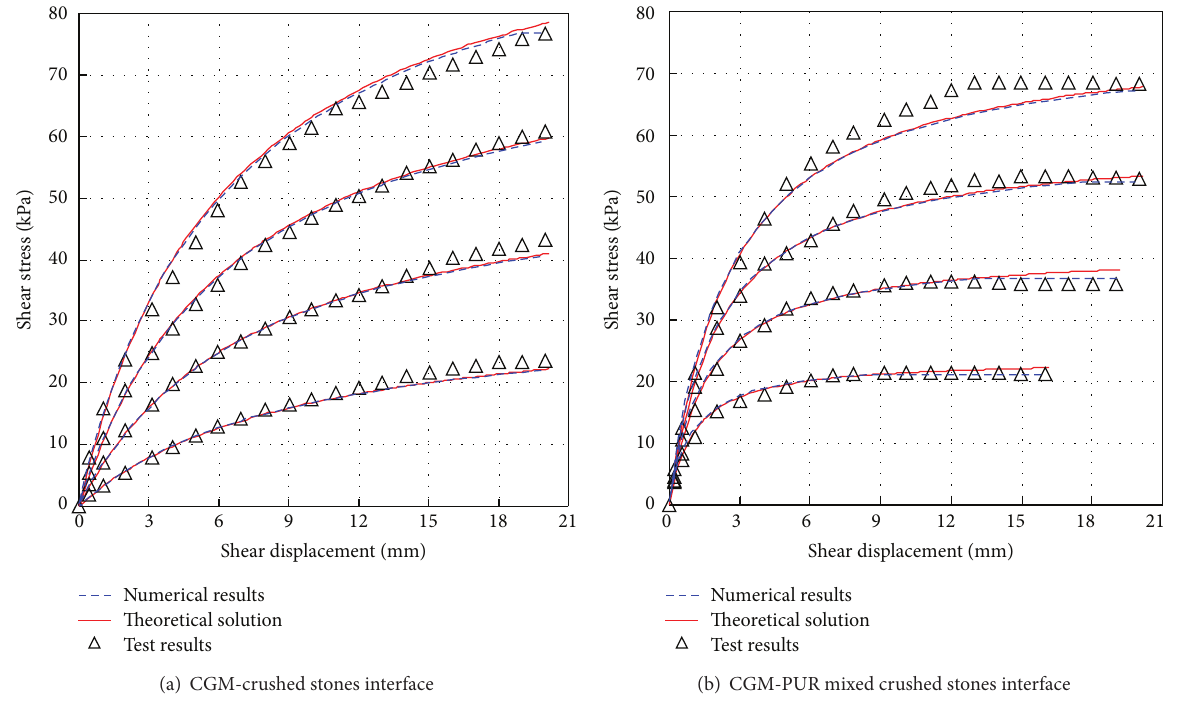
Figure 13: Comparison of numerical results with test results and theoretical solution of